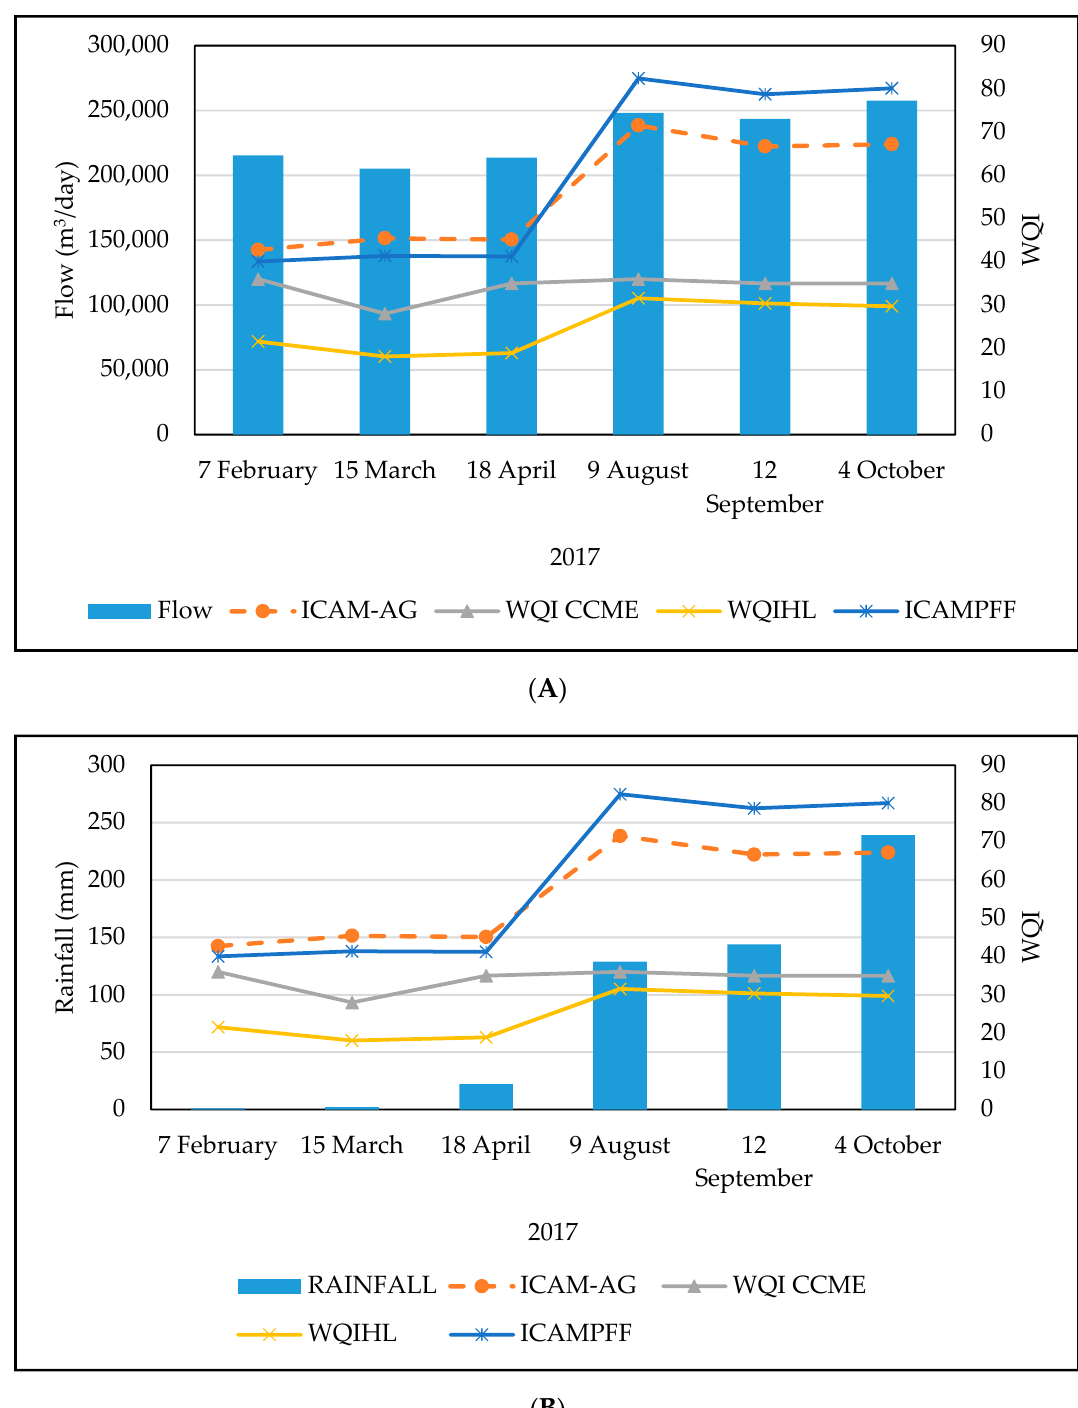
Figure 4. Variation of the WQI for the dumping point (P2) of the submarine outfall and: ( A ) Flow of the submarine Outfall ( B ) Rainfall.